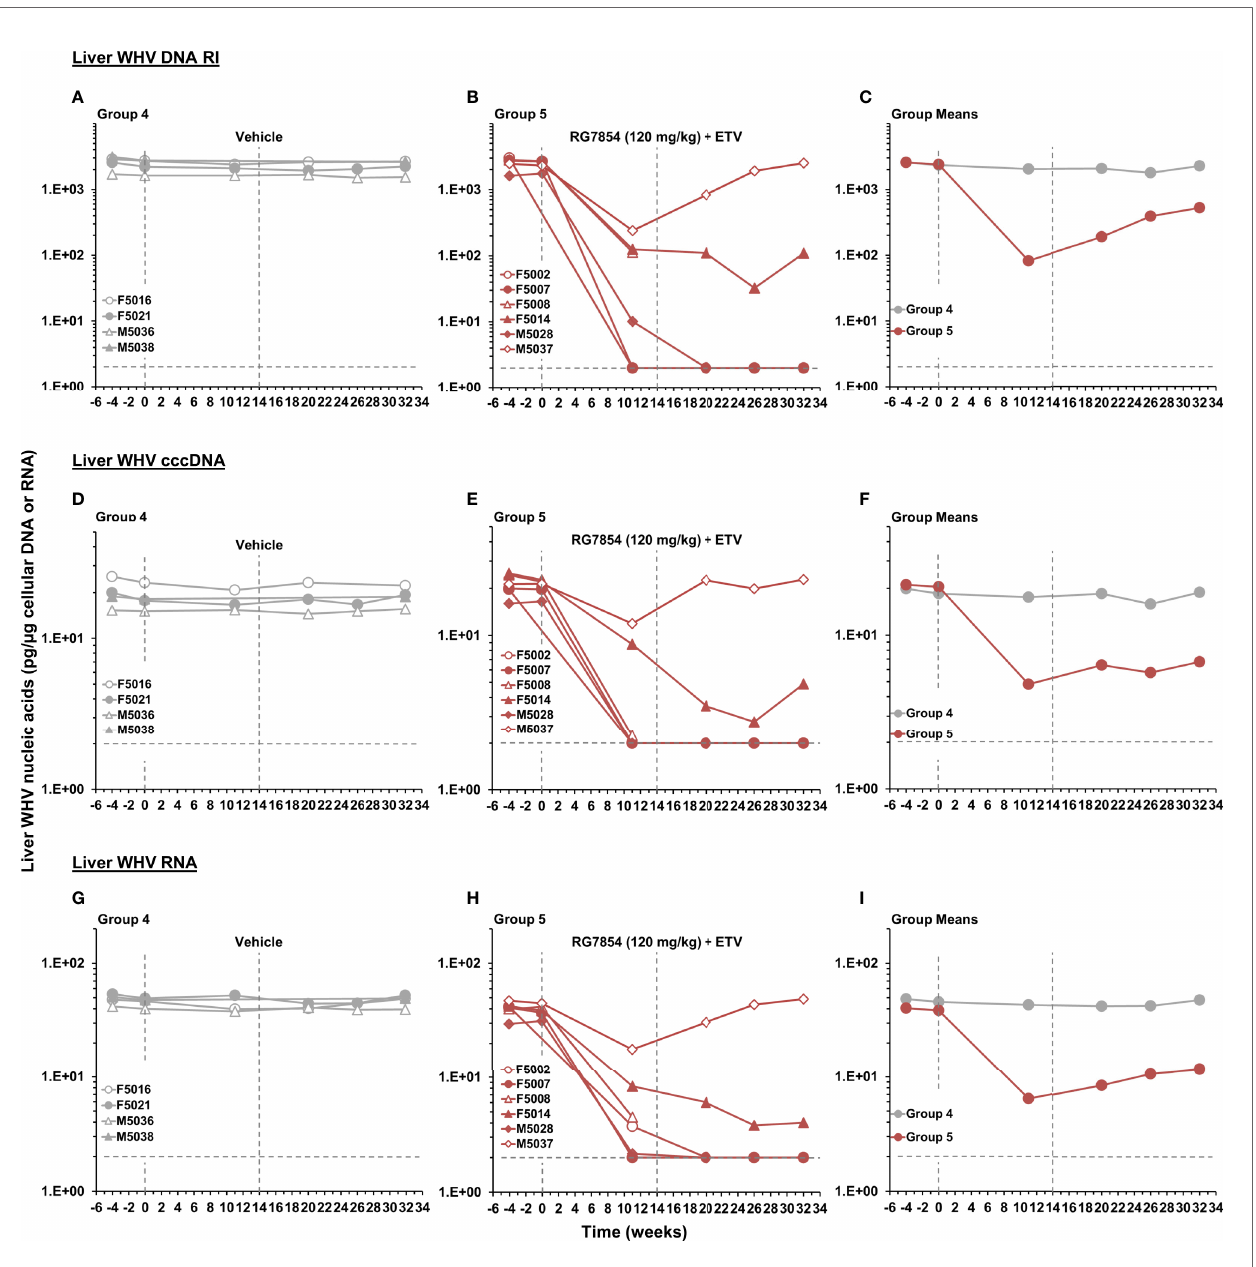
FIGURE 5 | Effect of RG7854 together with ETV on liver viremia levels. Kinetics of WHV DNA RI, cccDNA, and RNA loads in individual woodchucks administered (A, D, G) placebo or (B, E, H) RG7854 at a dose of 120 mg/kg plus ETV in the combination treatment study. (C, F, I) Group mean WHV nucleic acids. The vertical dotted lines represent the duration of 14-week combination treatment. The horizontal dotted lines indicate the detection limit for WHV nucleic acids by quantitative Southern and Northern blot hybridization (i.e., 2 pg/µg cellular DNA or RNA). The mean WHV DNA RI, cccDNA, and RNA loads in Group 5 were signi fi cantly reduced compared to Group 4 at weeks 11, 20 and 32, at weeks 11 and 32, or at weeks 11, 20, and 32, respectively ( P < 0.05) (Student ’ s t